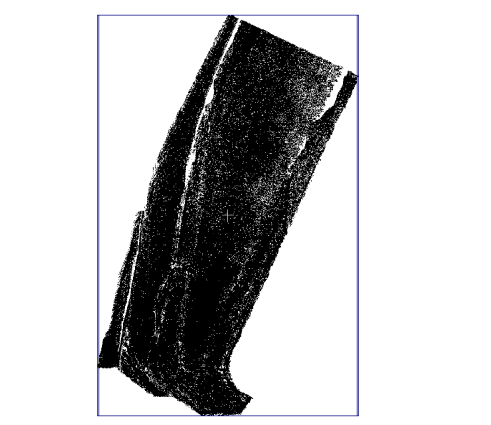
Figure 24. The result for match bounding-box centers registration method – the registered point cloud data